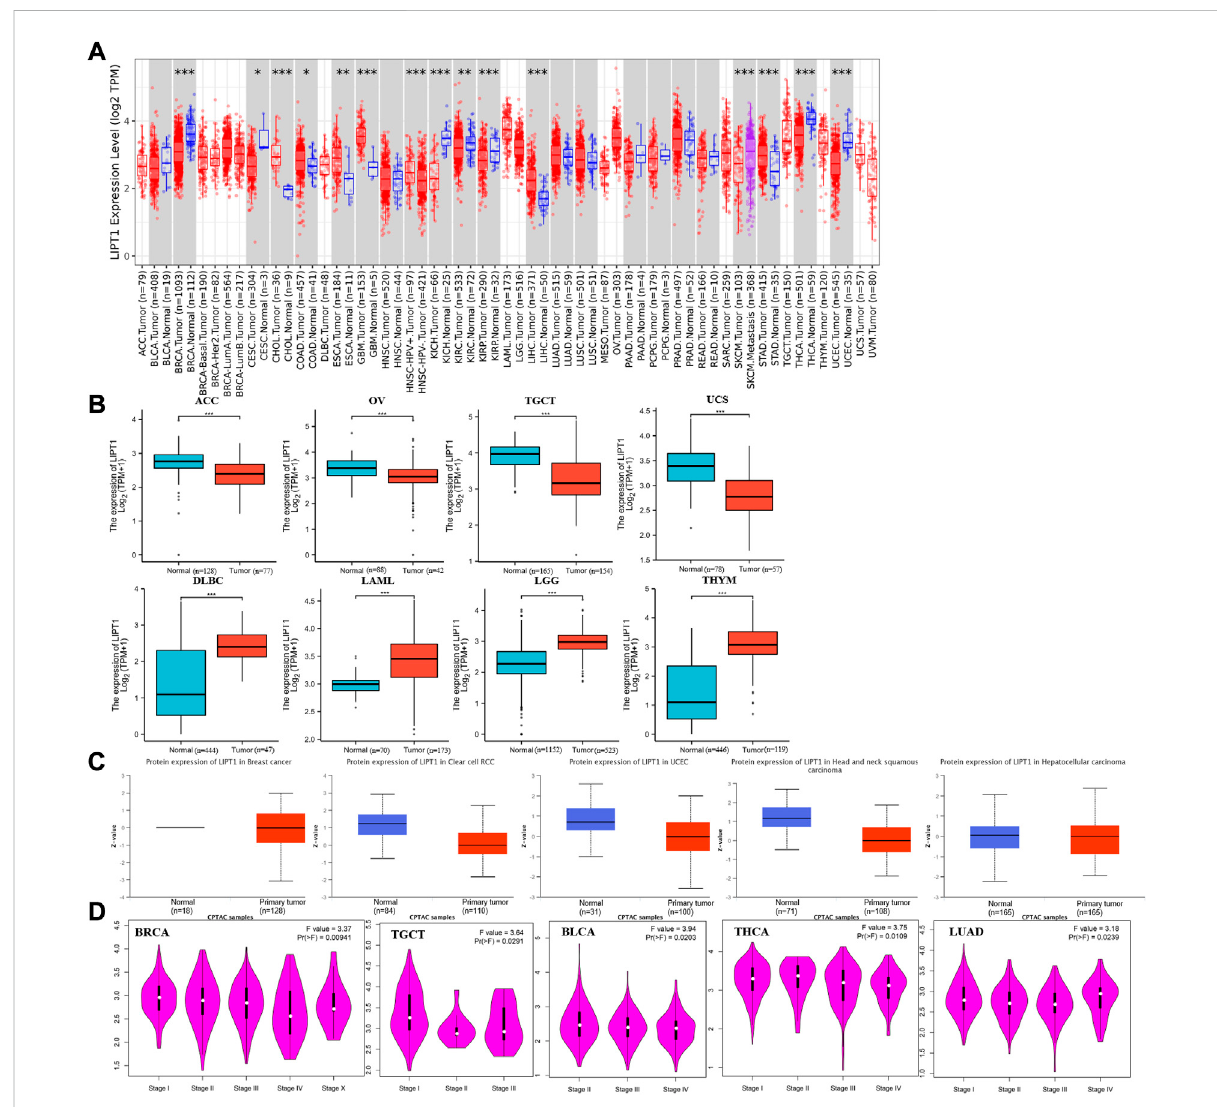
FIGURE 1 The expression of LIPT1 in pan-cancer. (A) LIPT1 expression in different cancers from TIMER2.0. * p < 0.05; ** p < 0.01; *** p < 0.001. (B) The expression differences of LIPT1 in ACC, OV, TGCT, UCS, DLBC, LAML, LGG, and HNSC from GTEx and TCGA. *** p < 0.001. (C) The protein levels of LIPT1 in BRCA, KIRC, UCEC, HNSC, and LIHC were analyzed using CPTAC. (D) LIPT1 expression levels and the pathological stages were analyzed using